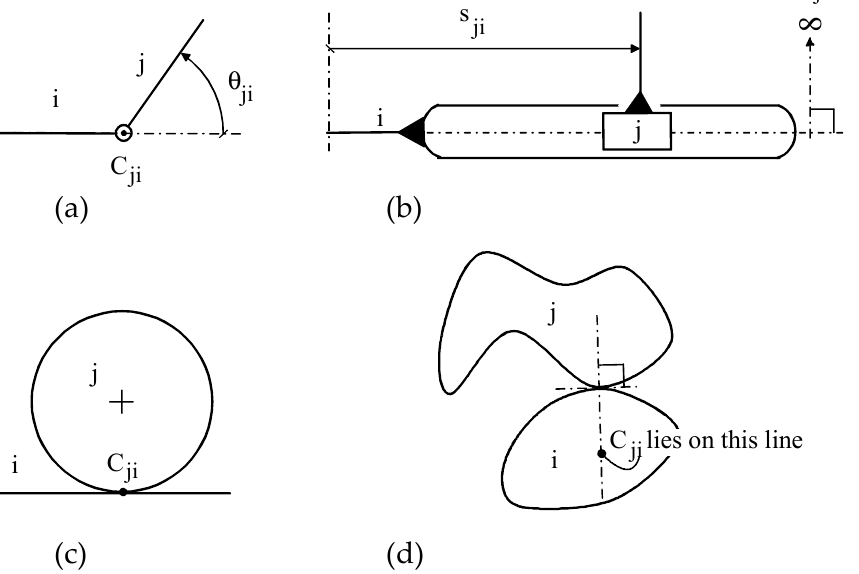
Figure 2. Position of the IC, C ji , in the four kinematic pairs that can appear in PMs: ( a ) revolute pair, ( b ) prismatic pair, ( c ) rolling contact, and ( d ) slipping contact.